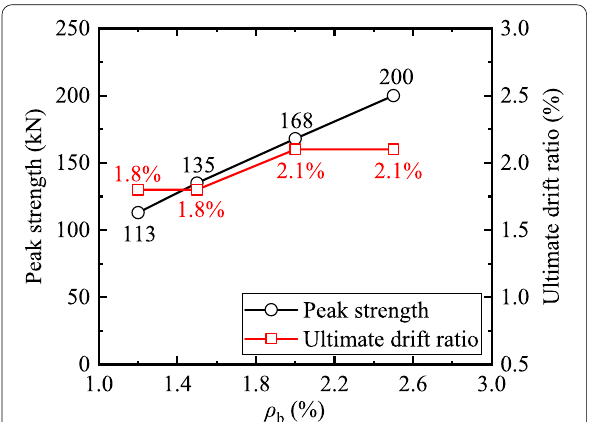
Fig. 23 Peak strength and ultimate drift ratio of specimens versus concrete cube compressive strength.